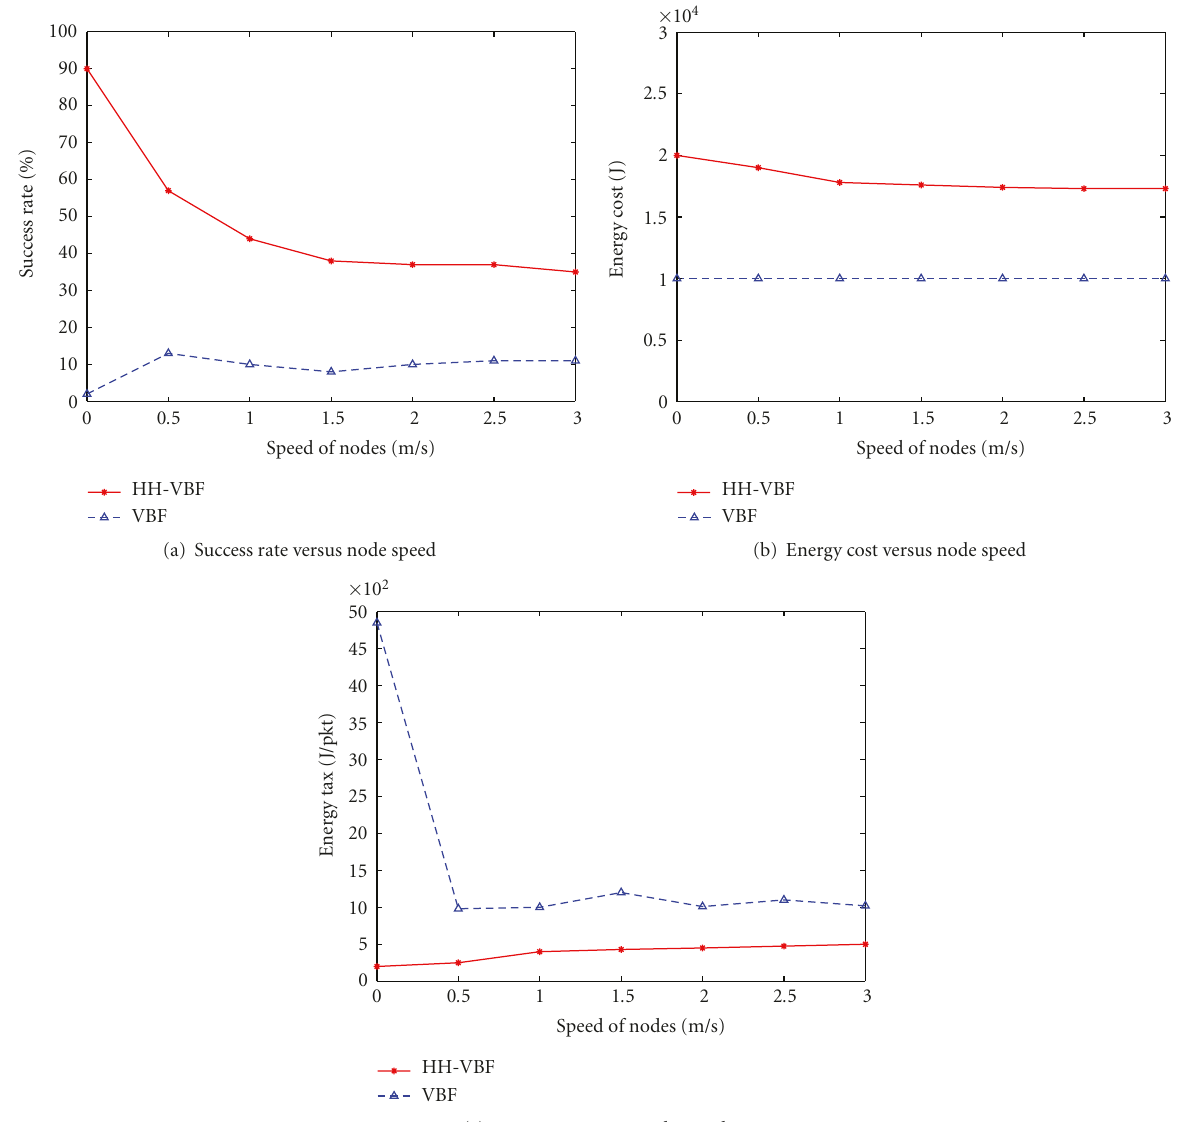
Figure 8: The performance of HH-VBF with varying node